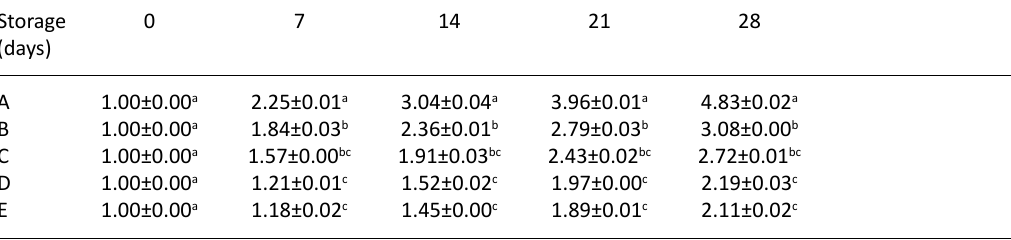
Table 4. Decay index (mark) of mango fruit pre-coated by different MC-Car solutions during storage Storage